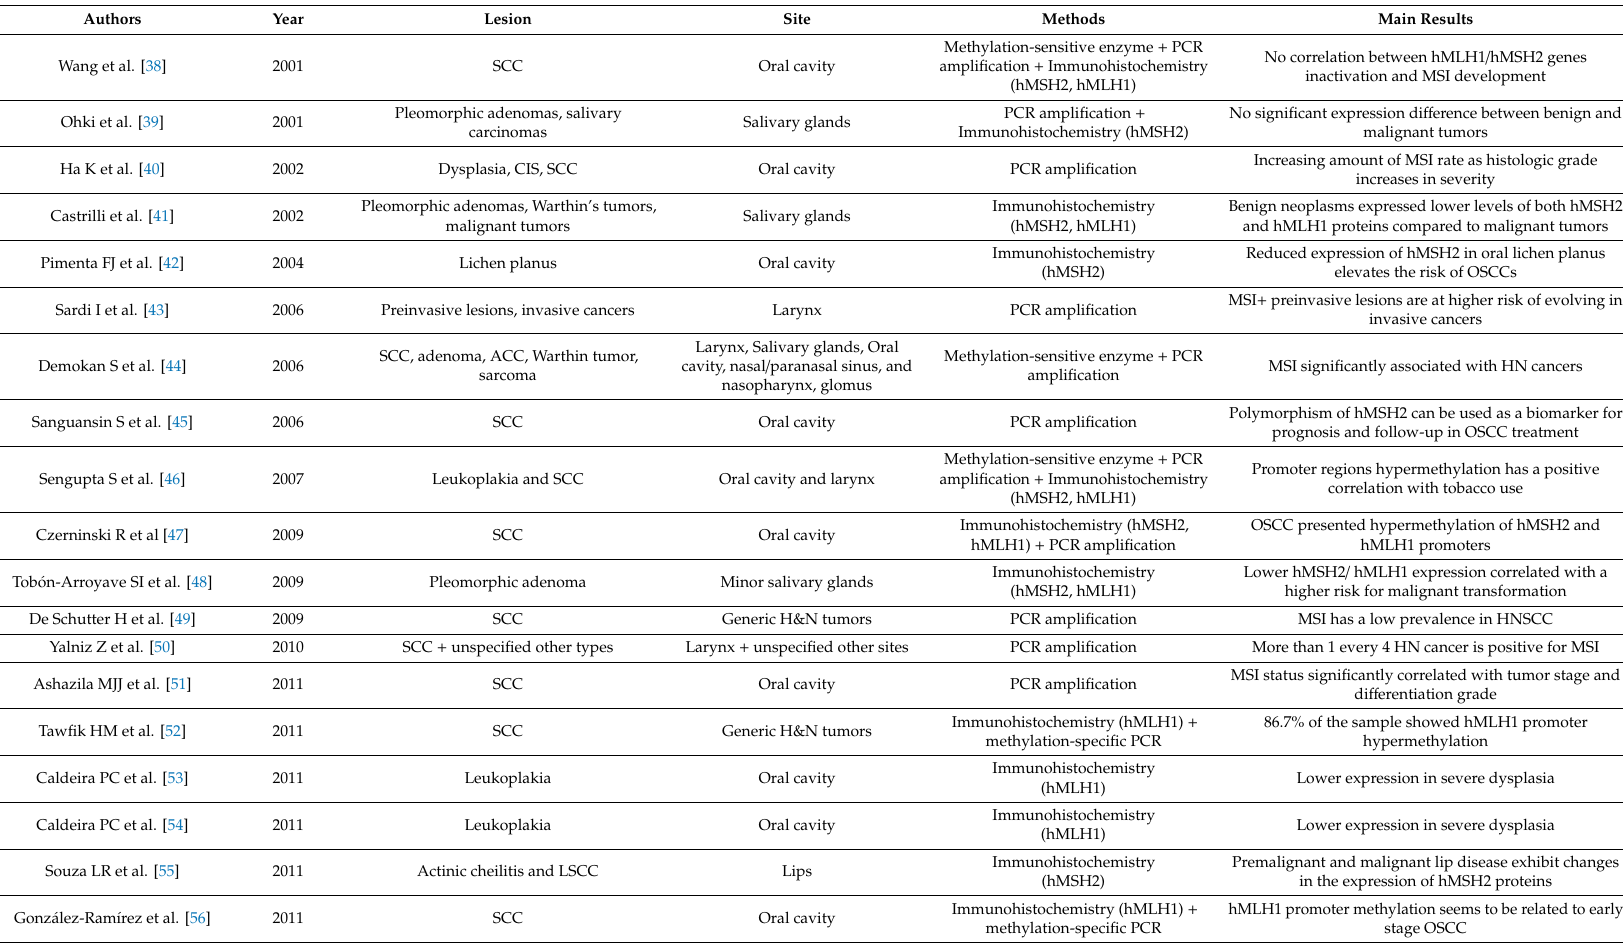
Table 1. A summary of the most important studies on the role of microsatellite instability (MSI) and MMR dysfunction in the progression of head and neck cancer (HNC) precancerous lesions. ACC, adenoid cystic carcinoma; CIS, carcinoma in situ; SCC, squamous cell